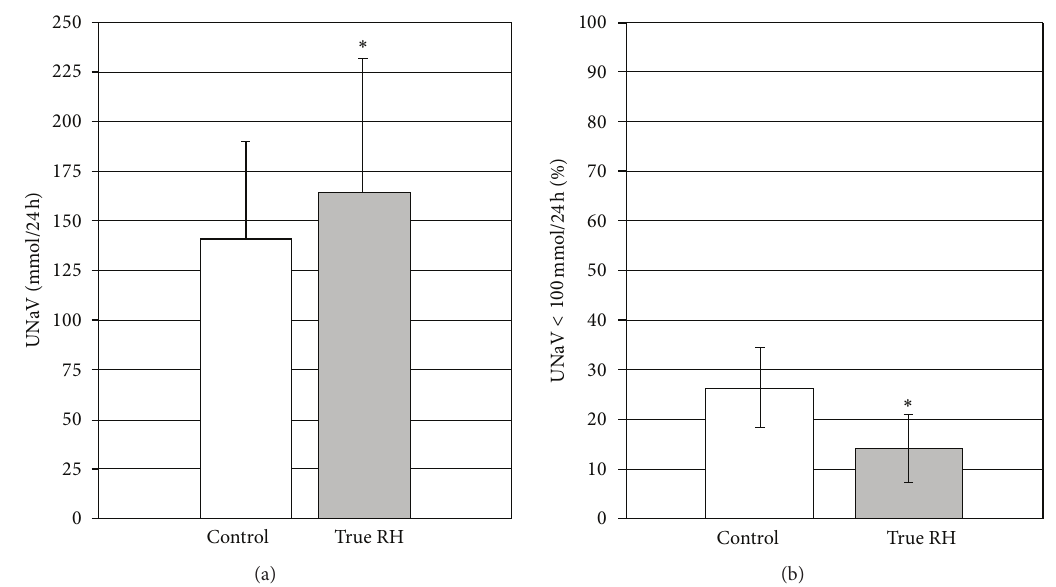
Figure 3: Mean urinary sodium excretion (UnaV, mmol/24 h) and prevalence of low-salt diet (UnaV < 100mmol/die, %) in CKD patients with controlled BP (control, white bars) and with true RH (gray, bars) [17]. ∗ 𝑃 < 0.05 versus